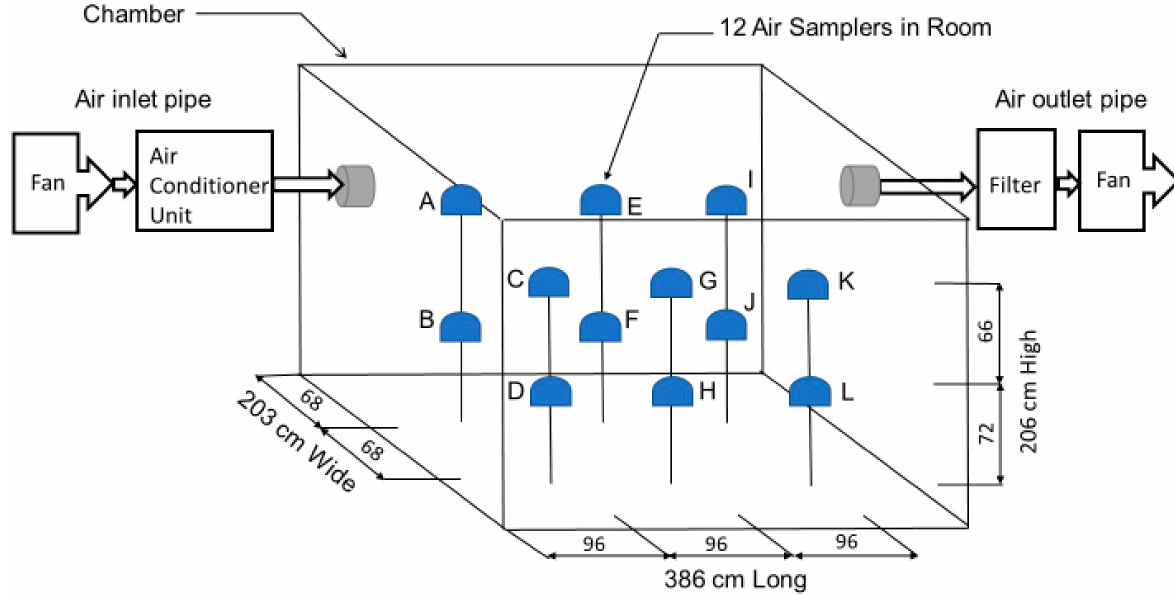
Figure 4. Hospital model room dimensions and locations of the PM2.5 samplers. Samplers A, C, E, G, I, and K are all upper samplers 136 cm above the ground and 66 cm above the lower samplers. The lower samplers B, D, F, H, J, and L are 72 cm above the ground.